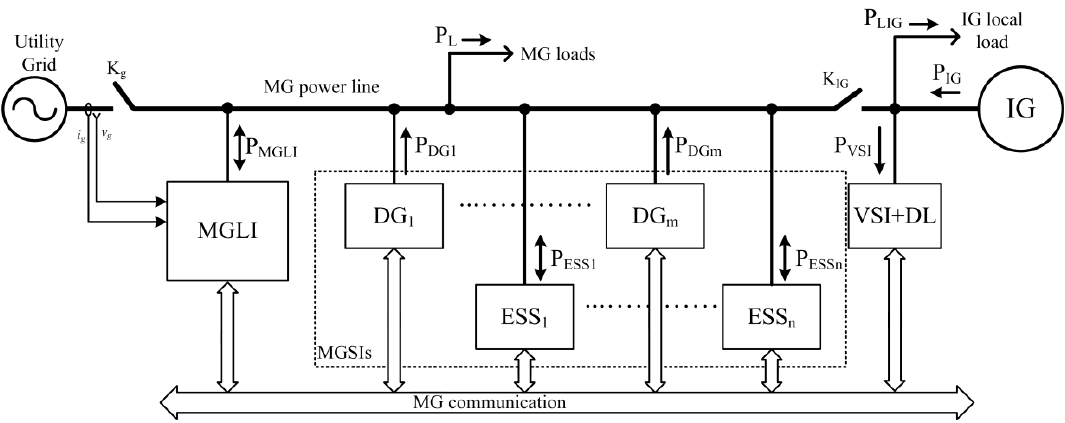
Figure 1. General topology of the microgrid (MG) with an integrated induction generator (IG) system.